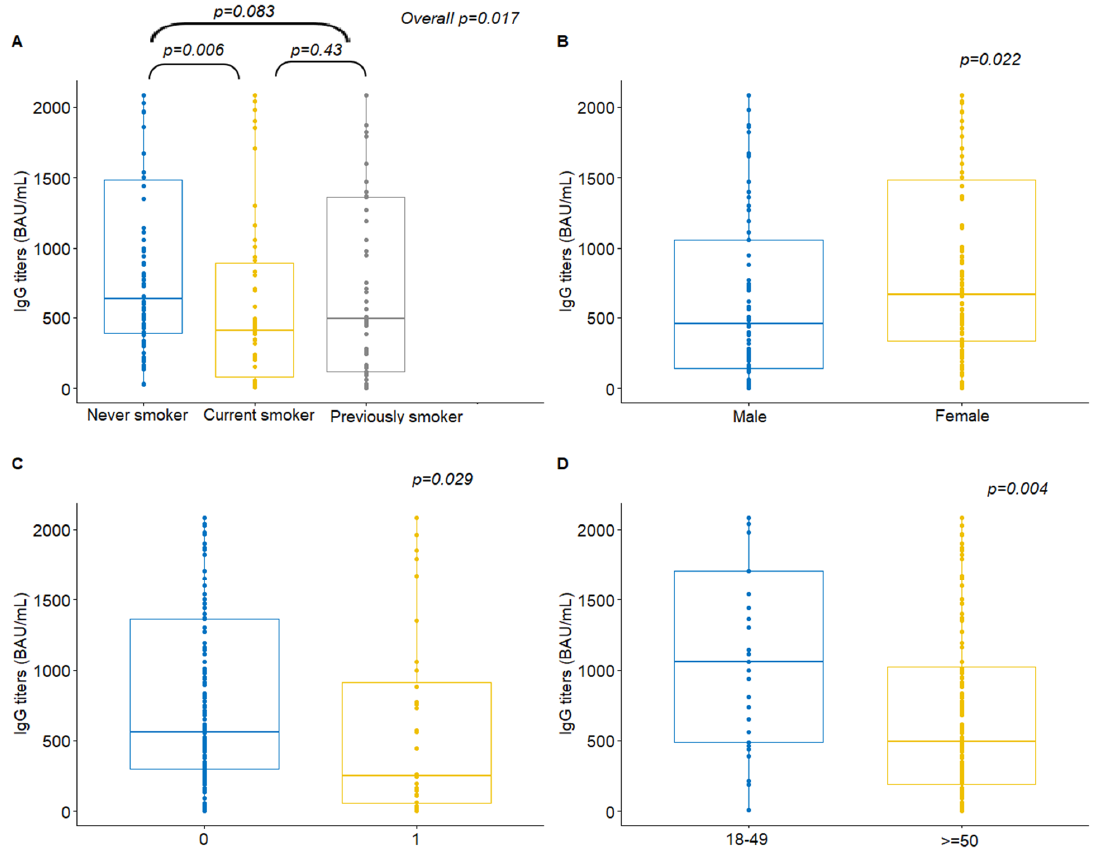
Figure 3. Anti-SARS-CoV-2 spike IgG antibodies by ( A ) smoking status, ( B ) gender, ( C ) performance status and ( D ) age among patients with cancer. Regarding cancer type, patients with small-cell lung cancer (SCLC), colorectal and pancreatic cancer had considerably lower antibody titers as opposed to patients with breast or ovarian cancer (Supplementary Materials, Figure S1). Comparison of IgG anti- bodies in the subgroup of patients with breast, NSCLC, SCLC, pancreatic, colorectal and ovarian cancer showed a significant difference among them, with ovarian cancer patients achieving the highest median number of antibodies among all, and those with pancreatic cancer the lowest ( p = 0.041). Regarding antineoplastic treatment, patients treated with endocrine therapy only and radiotherapy alone had considerably higher antibody titers; however, due to the small number of cases in these treatment groups, no formal comparisons were performed. Further categorization of age showed that patients aged 18–49 had higher antibody rates compared to those aged 50 and over (median value 1060 versus 491.5, p = 0.004, Fig- ure 3D) (Table 2). No correlation was found among patients and controls between the number of antibody titers and the number of comorbidities (Spearman rho = −0.13, p = 0.076 and rho = −0.03, p = 0.79, respectively) or the time interval between the serum sample and the date of second vaccination (rho = −0.02, p = 0.74 and rho = −0.13, p = 0.21, respec- tively) (Supplementary Materials, Figure S1).